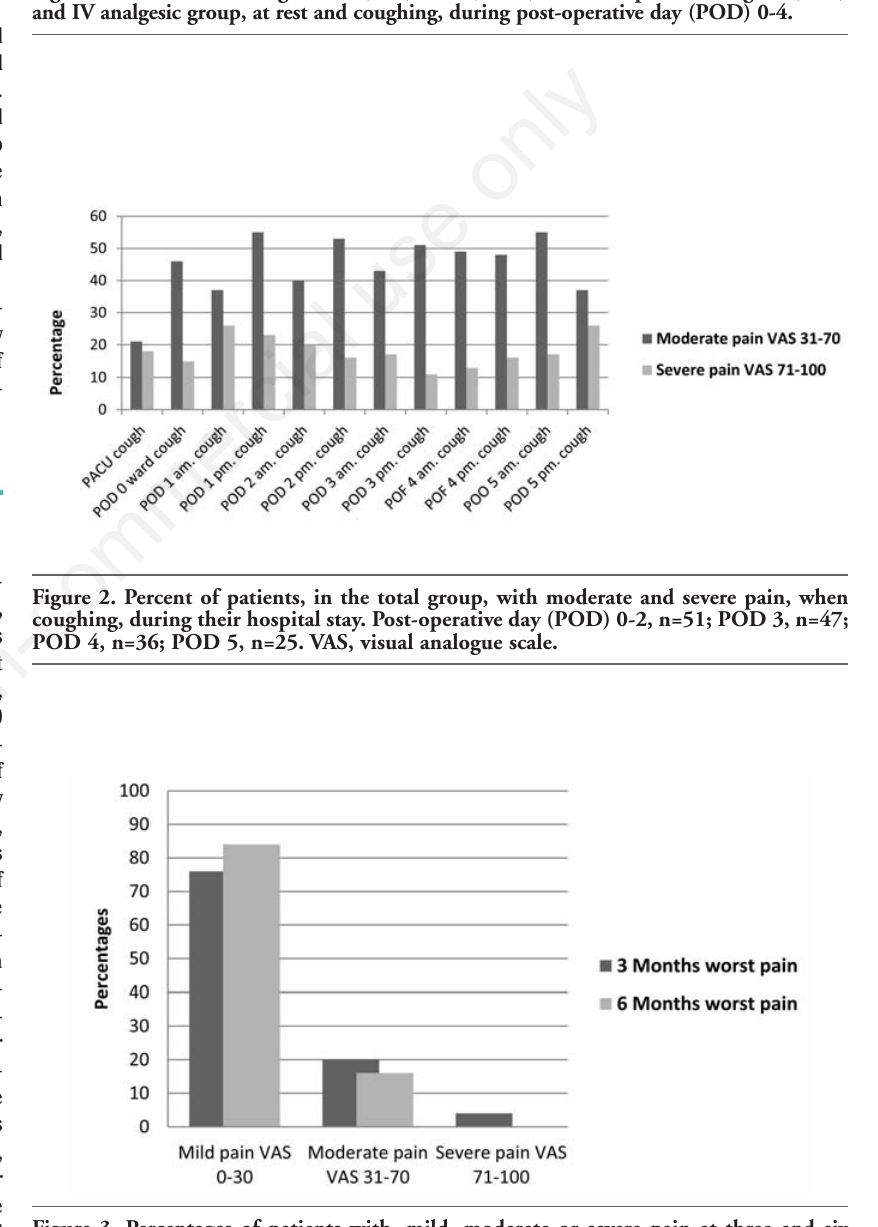
Figure 3. Percentages of patients with, mild, moderate or severe pain at three and six months, n=49. VAS, visual analogue